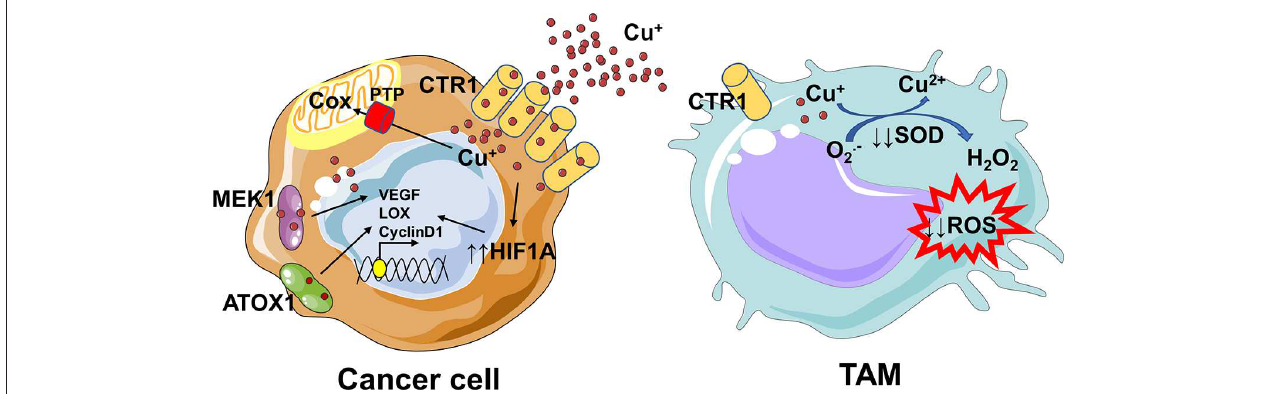
FIGURE 3 | Copper addiction of cancer cells could prevent the pro-inflammatory phenotype of macrophages. The increased copper flow via CTR1 is followed by loading onto the copper chaperone ATOX1, which acts as a copper-dependent transcription factor promoting cyclin D1 expression and cell replication. Since copper is essential for the activity of proteins, like cytochrome c oxidase (Cox), involved in the mitochondrial electron transport chain, mitochondria rely on the phosphate carrier SLC25A3 (PTP) for its uptake. Copper not only binds to proteins directly involved in cancer progression, such as MEK1, but also indirectly modulates their expression or activation. Copper inhibits prolyl hydroxylase thus stabilizing HIF-1 α and increasing the transcription of several angiogenic genes (e.g., ceruloplasmin and VEGF) and genes involved in the epithelial to mesenchymal transition (e.g., LOX). Copper is essential for sustaining the pro-inflammatory phenotype of macrophages; indeed, as a component of the SOD enzyme which catalyzes the production of H 2 O 2 from superoxide, it contributes to the ROS-dependent killing capacity of macrophages. The removal of copper from microenvironment by cancer cells might drive the polarization of TAMs toward a pro-tumoral M2-like phenotype. In parts the figures are based on speculations and have been prepared by assembling in-house built cellular metabolic pathway outlines with a modified and adapted version of BioRender